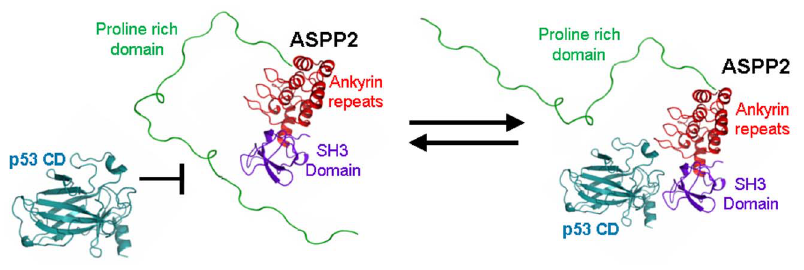
Figure 8. The proposed model [ 13 ] : The disordered ASPP2 Pro regulates the intermolecular interactions of ASPP2. The disordered ASPP2 Pro binds to the ASPP2 Ank-SH3 domains and inhibits their protein-protein interactions. Inhibition of the domain-domain interaction makes the Ank-SH3 available to binds its partner proteins such as p53CD.